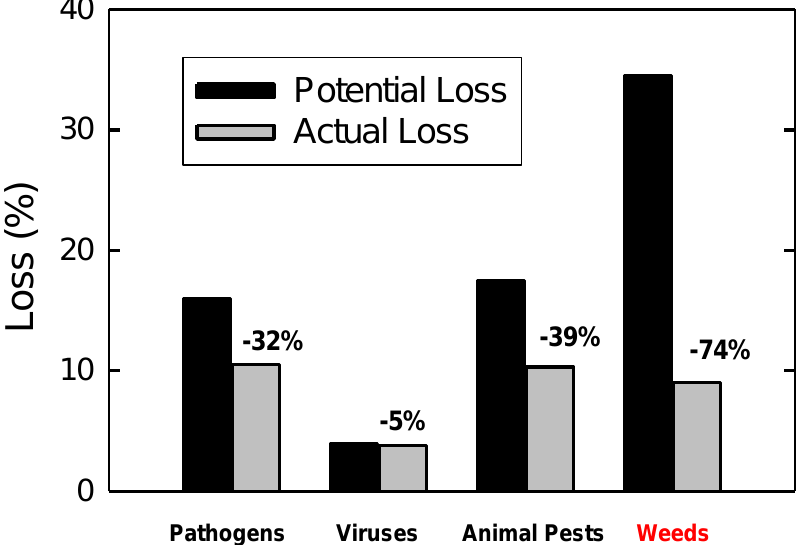
Figure 1. Potential and actual crop loss by pests. Differences in value reflect the ability to control the pests and reduce damage to crop production. Note that weed management provides the greatest reduction in weed-induced crop losses. Adapted from [16].